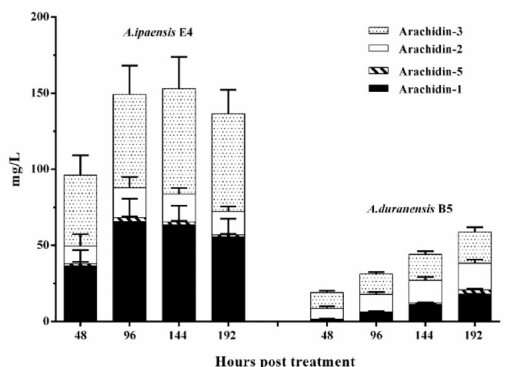
Figure 7. Yield of prenylated stilbenoids in hairy root cultures of Arachis ipaensis and A. duranensis . Hairy root cultures were elicited 125 µ M MeJA, 18 g / L CD, 3 mM H 2 O 2 and 1 mM MgCl 2 in a 100 mL elicitation medium. Yield expressed in mg / L and each bar represents the average of 3 biological replicates and error bars represent standard